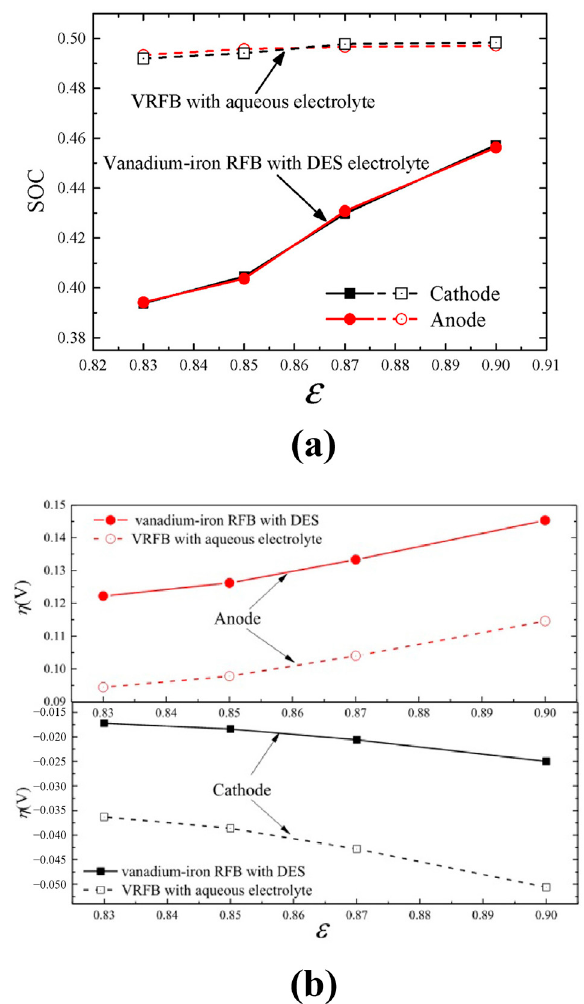
Figure 7. Comparative investigation between vanadium-iron RFB with DES and VRFB with aque- ous electrolyte. ( a ) Comparison of average SOC in the anode and cathode. ( b ) Comparison of overpotential in the anode and cathode [42] .